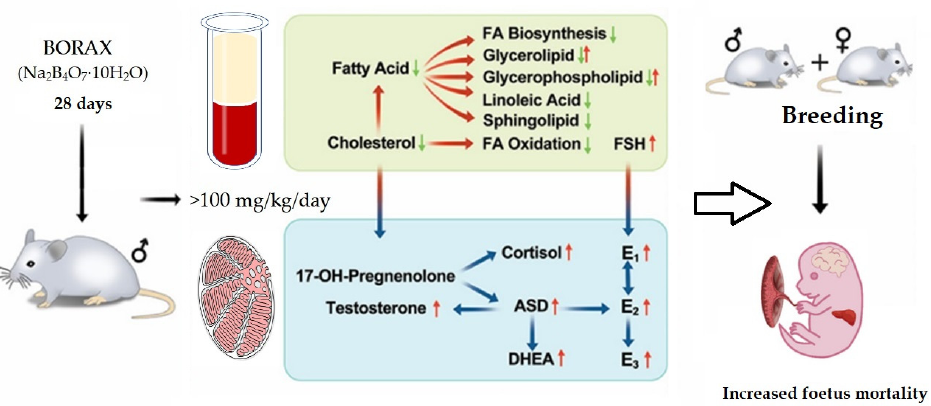
Figure 5. Reproductive toxicity and metabolic perturbations in male rats exposed to boron (as borax). Modified from [18]. FA: fatty acids, FSH: folicule stimulant hormone, DHEA: dehydroepiandrosterone, ASD: androstenedione, E1: estrone, E2: E2, E3: estriol.